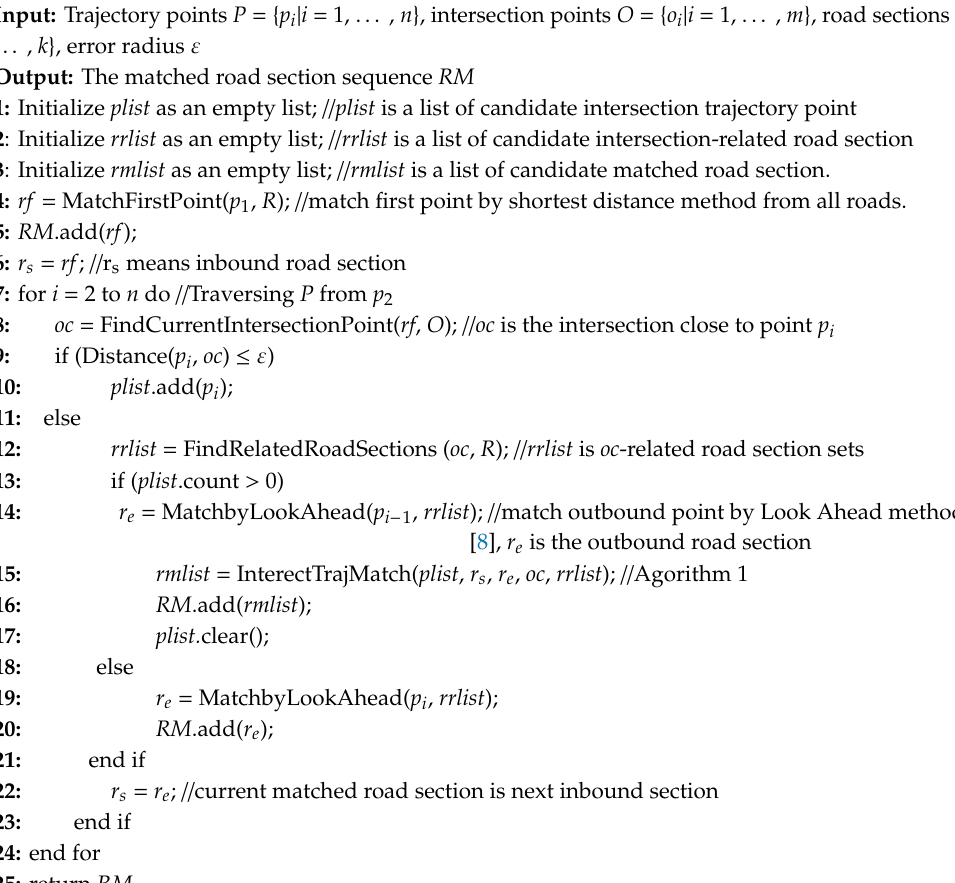
Algorithm 2 Segmented trajectory matching